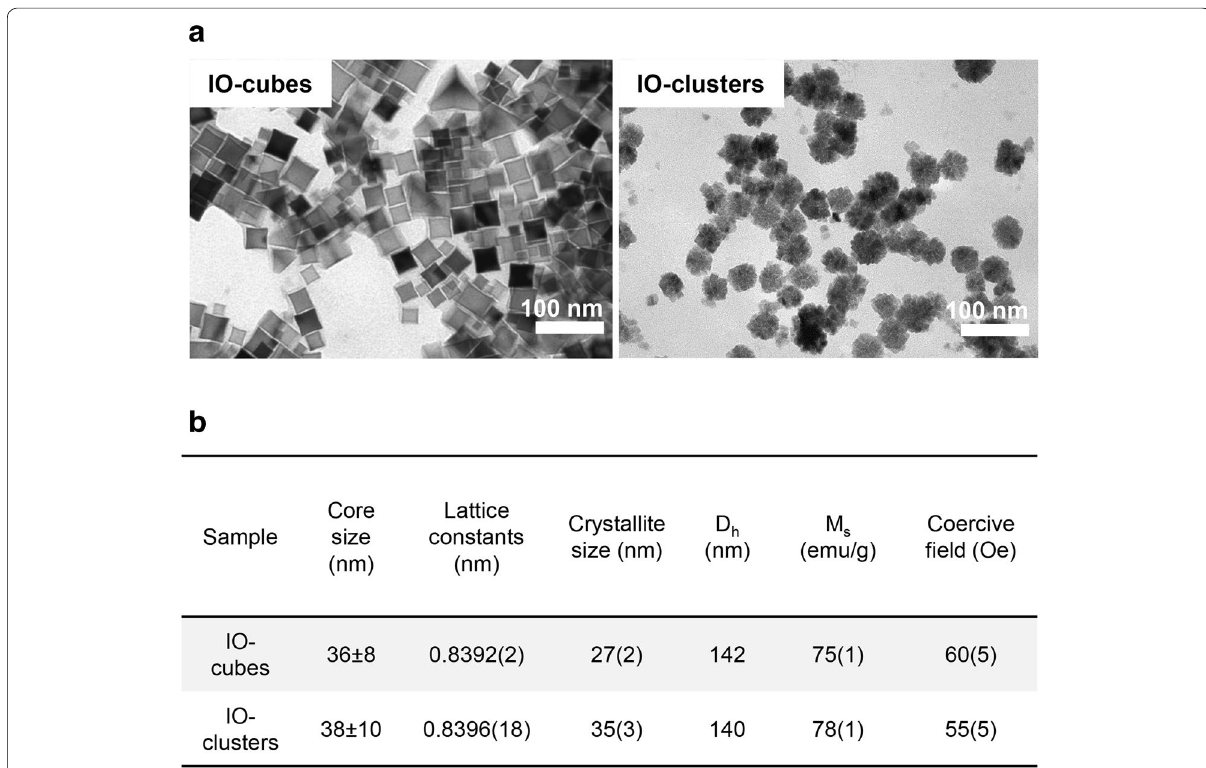
Fig. 1 Physicochemical characterization of the iron oxide nanocubes (IO-cubes) and nanoclusters (IO-clusters). a Transmission electron micrographs of the iron core of the nanoparticles. b Physicochemical properties of IO-cubes and IO-clusters ( D h hydrodynamic diameter, M s saturation